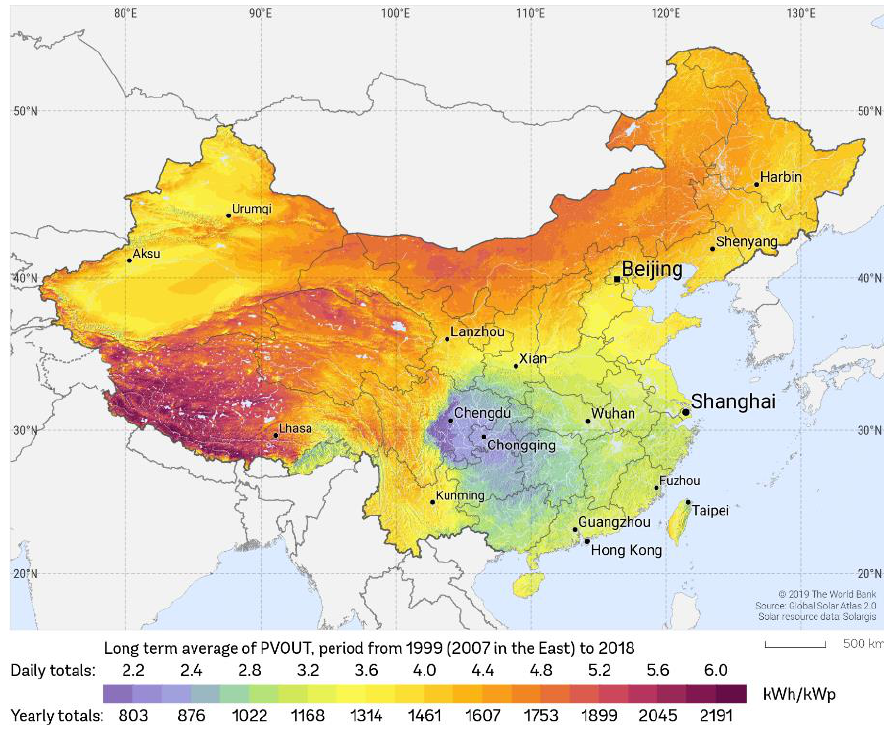
Figure 1. Distribution of solar resources in China [21].